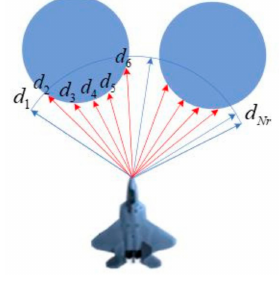
Figure 2. UAV sensed